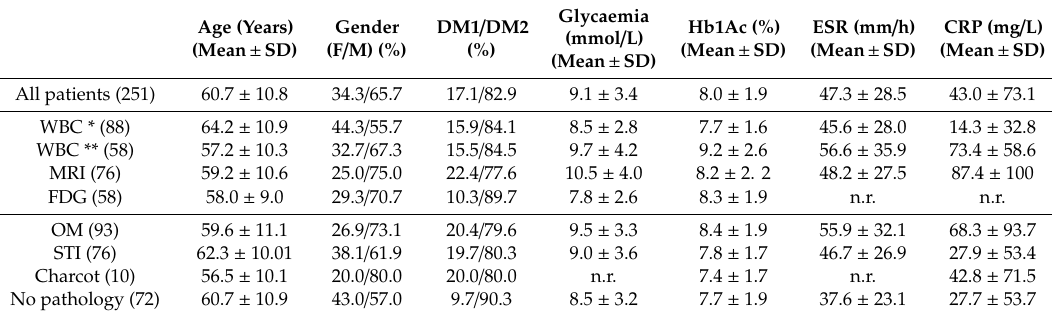
Table 1. General characteristics of the study population.